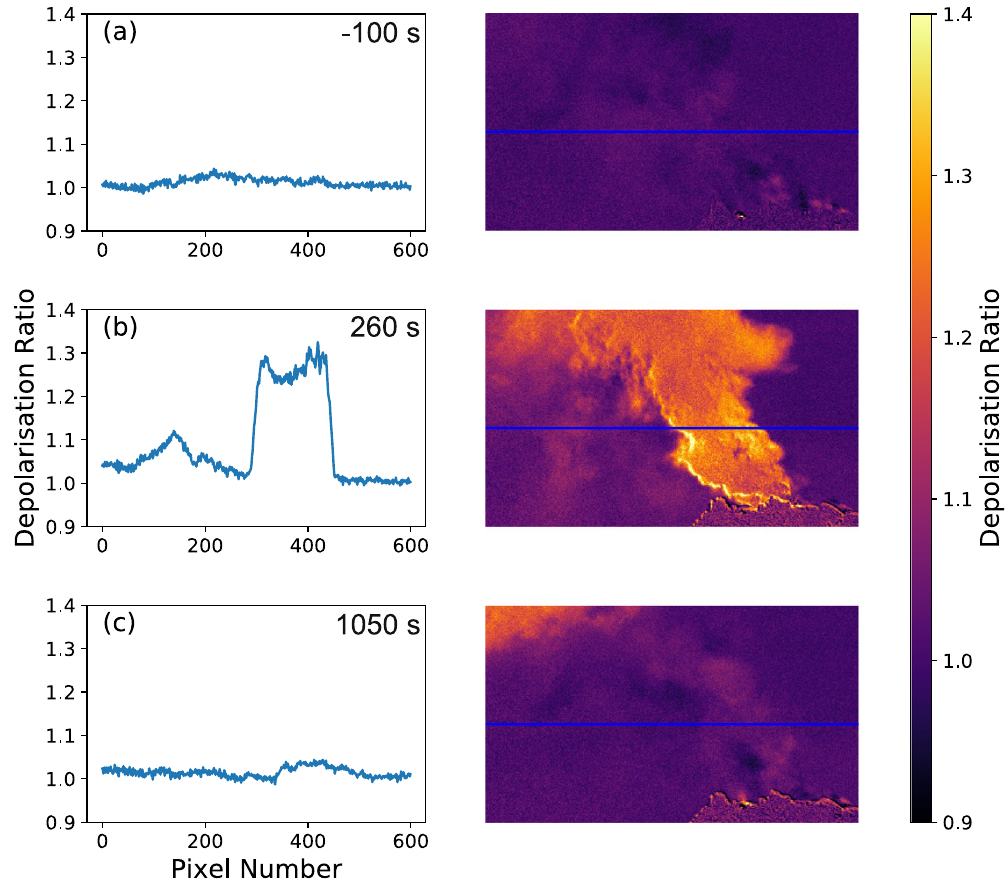
Figure 2. Example depolarisation images before ( a ), during ( b ) and after ( c ) an explosion at Santiaguito. The timings are relative to the onset of the explosion. The graphs depict the cross-sections indicated by the blue lines on the images. The cross-sections are averaged across 10 pixels vertically.